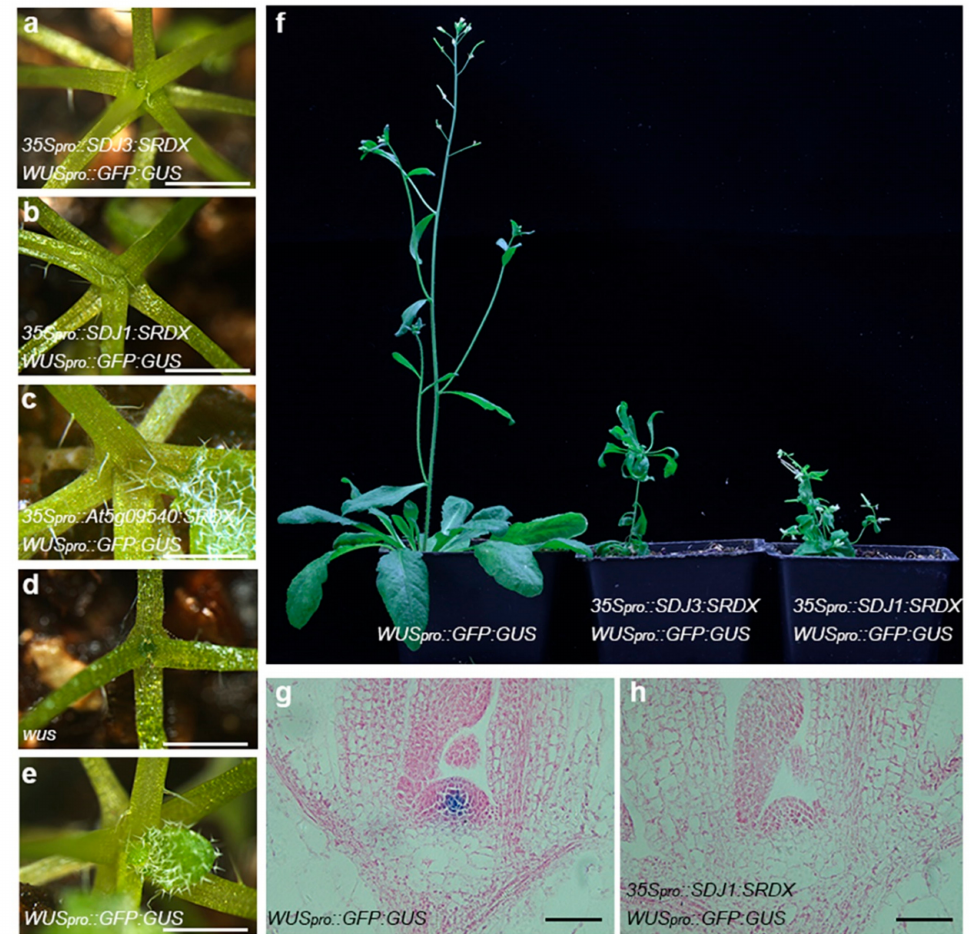
Figure 3. Overexpression of DnaJ-SRDX protein inhibits SAM development in Arabidopsis. ( a – e ) The premature termination of SAM in strong lines of 35S pro ::SDJ3-SRDX WUS pro ::GFP:GUS plant ( a ), 35S pro ::SDJ1-SRDX WUS pro ::GFP:GUS plant ( b ), 35S pro ::At5g09540-SRDX WUS pro ::GFP:GUS plant ( c ), and wus mutant ( d ) in comparison with that of WUS pro ::GFP:GUS control plant ( e ). ( f ) Phenotypes of weak lines of four-week-old 35S pro ::SDJ3-SRDX WUS pro ::GFP:GUS plant and 35S pro ::SDJ1- SRDX WUS pro ::GFP:GUS plant in comparison with WUS pro ::GFP:GUS control plant. ( g , h ) WUS promoter activity in 35S pro ::SDJ1-SRDX WUS pro ::GFP:GUS plant ( h ) in comparison with WUS pro ::GFP:GUS plant ( g ) examined by GUS staining. Scale bar = 5 mm in ( a – e ), 50 µ m in ( g , h